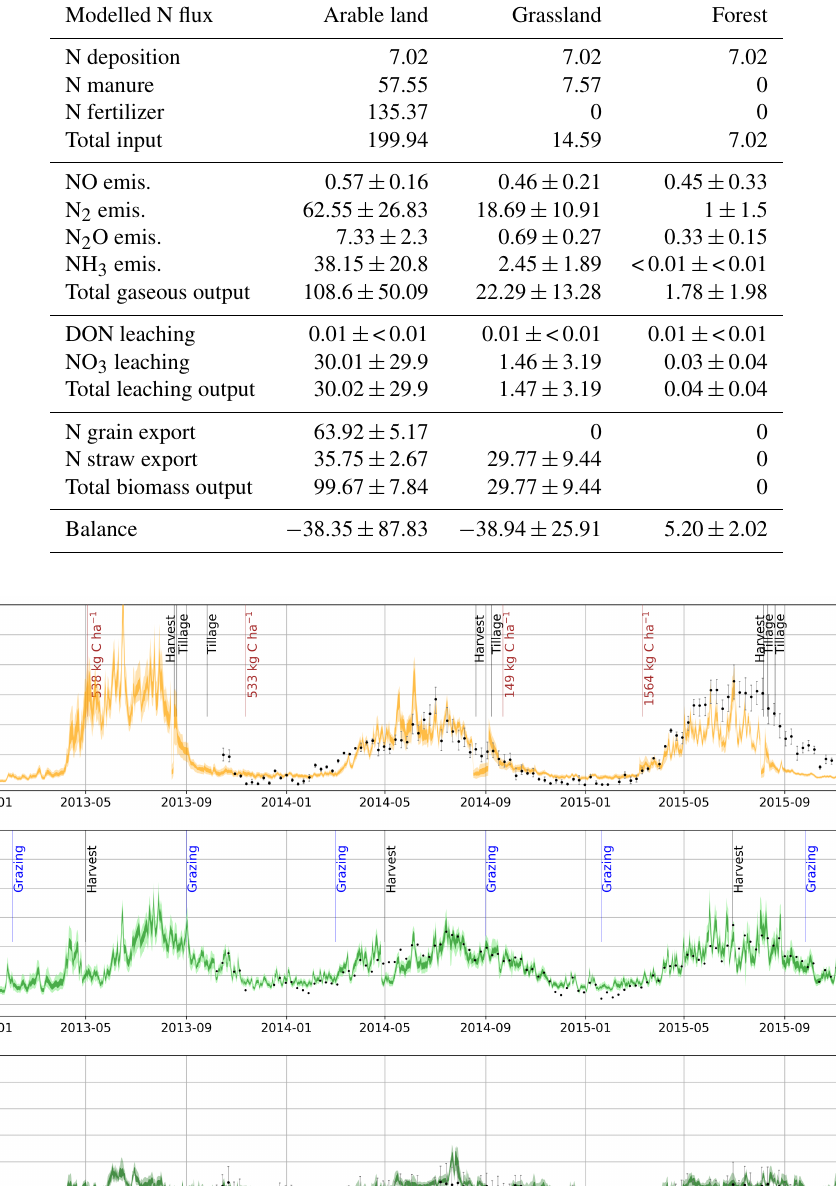
Table 4. Simulated nitrogen fluxes given by posterior model runs and their uncertainty on different land use in kg Nha − 1 a − 1 . N manure on grassland includes urine and dung input by sheep. Biomass output on grasslands combines harvest export and biomass leaving the system through sheep. Arable land model assumes 20% return of stubble to field.